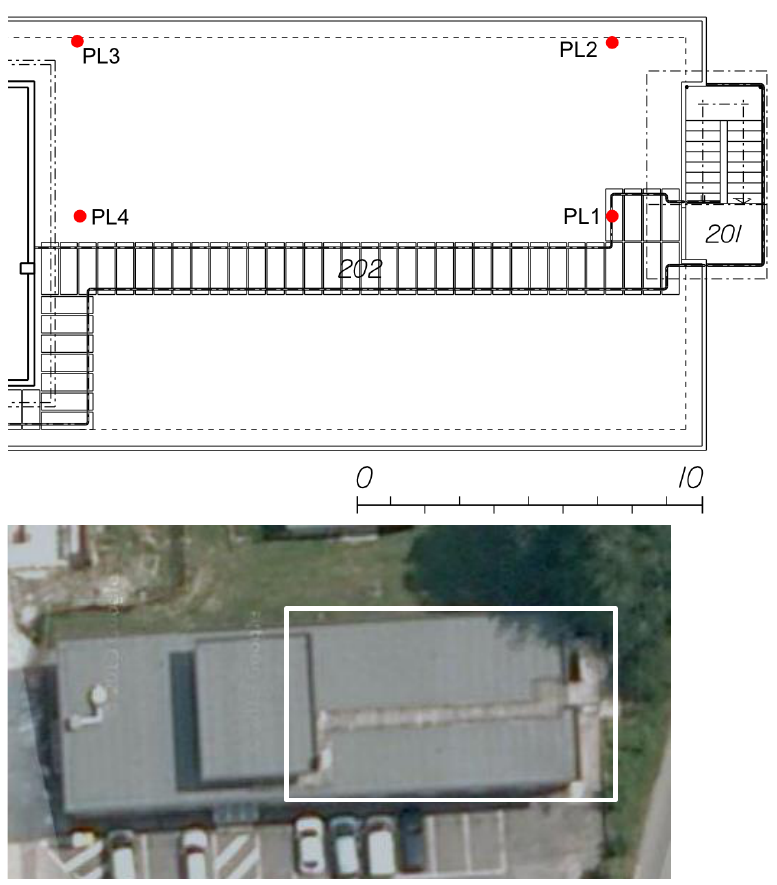
Figure 5. Outdoor scenario selected for the performance evaluation of hybrid pseudolite/GNSS